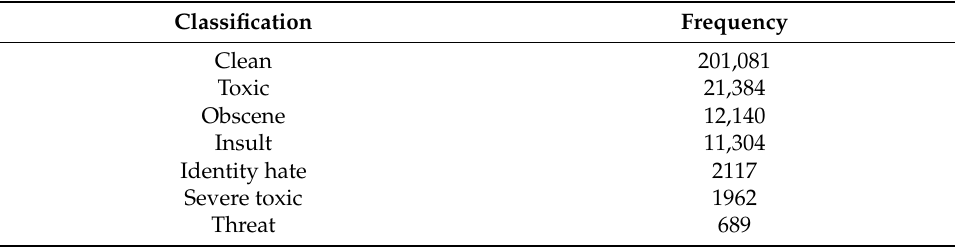
Table 2. Google Jigsaw dataset details.